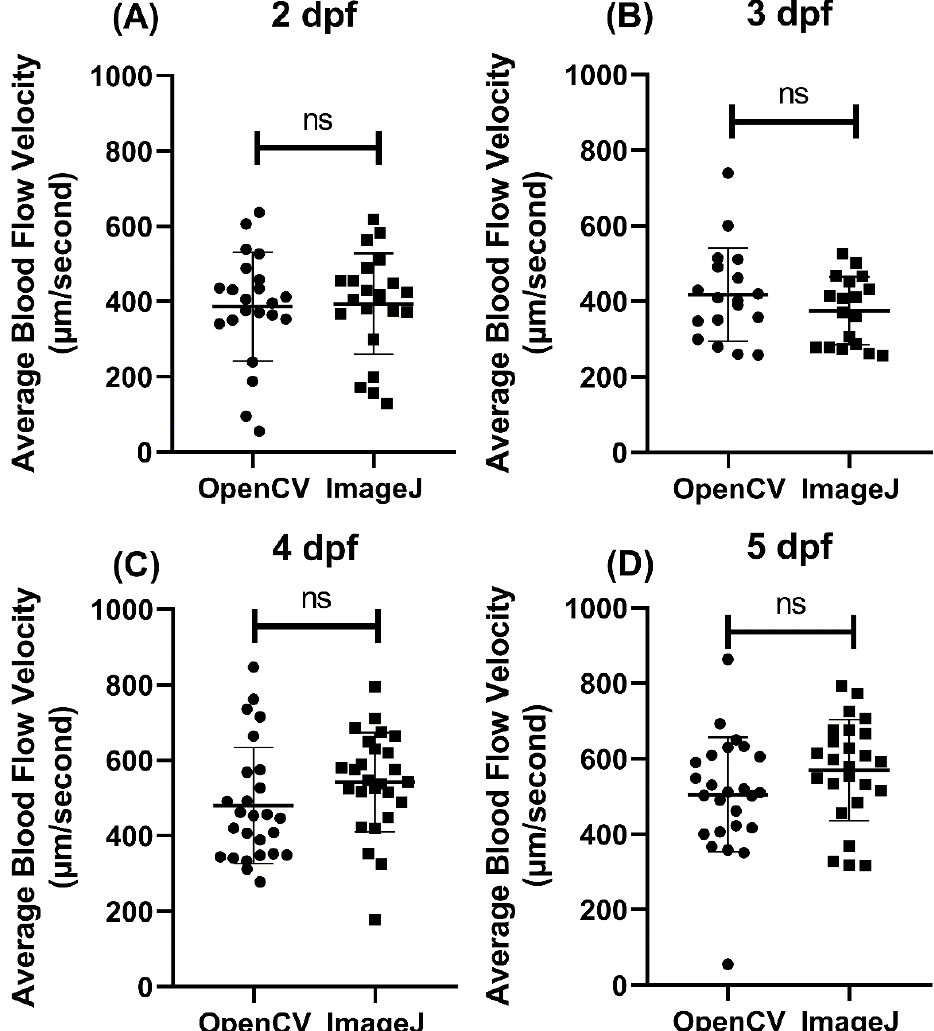
Figure 4. Validation of the performance of OpenBloodFlow GUI package for blood flow velocity measurement through comparison with ImageJ method. Zebrafish embryos aged ( A ) 2 dpf, ( B ) 3 dpf, ( C ) 4 dpf, or ( D ) 5 dpf were subjected to ImageJ and OpenCV methods to measure the average blood flow velocity. The data were shown as mean with standard deviation (circle dots show the data analyzed by OpenCV, while square dots show the data analyzed by ImageJ), and the significant difference was calculated by paired t -test. (ns = no significance, n = 18 – 26)